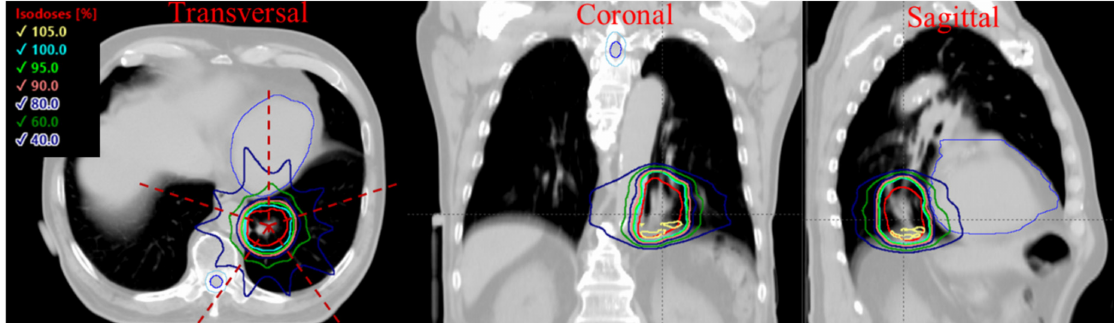
Figure 1. The 3D dose distribution of transmission plan using a 5-field arrangement. The dashed lines indicate the beam direction, and the red contour shows the